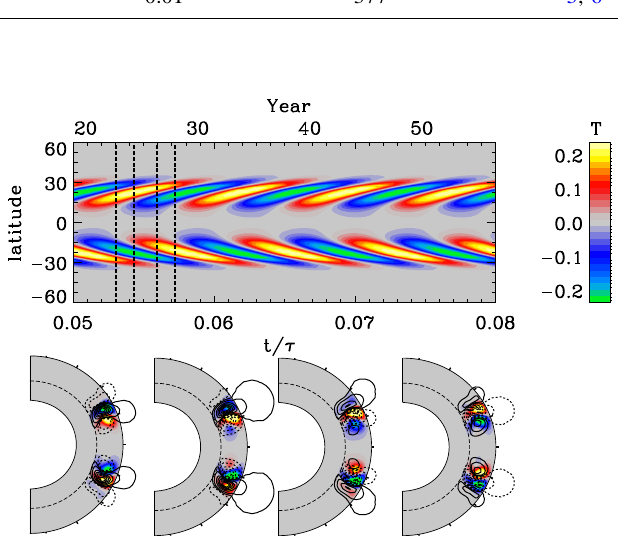
Fig. 2. A kinematic a 2 X dynamo solution. De fi ning parameters are listed in Table 1 (solution run 0). The toroidal fi eld component is plotted as a time-latitude diagram at depth r / R = 0.85 in the top panel, and meridional plane snapshots extracted at times corresponding to the dashed lines on the top panel, and spanning a magnetic half- cycle, are displayed at